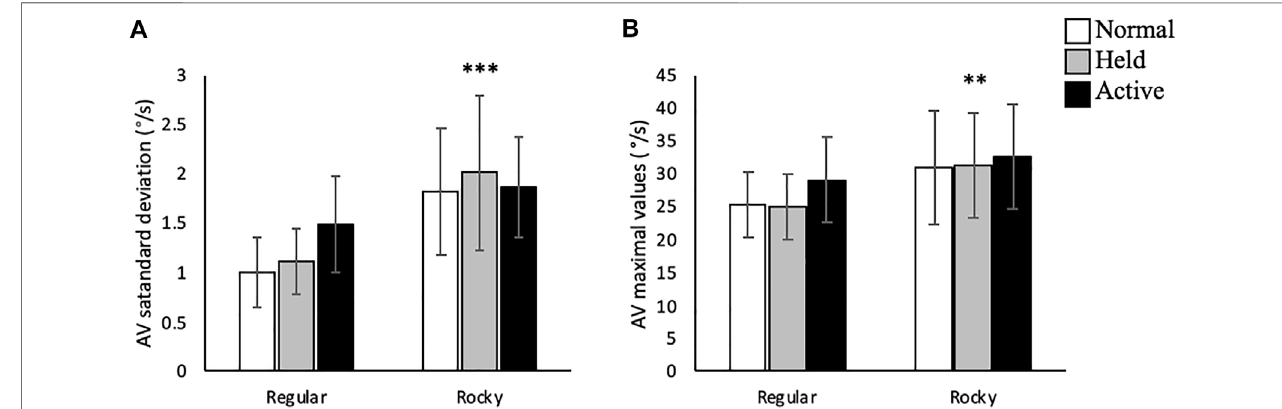
FIGURE6| Trunklinearvelocity (A) standarddeviation(m/s)and (B) maximalvalues(m/s)accordingtosurfacetypeforeacharmconditioninthemediolateralaxis. ** and *** shows that rocky surface led to larger values than regular surface at p < 0.01 and p < 0.001.